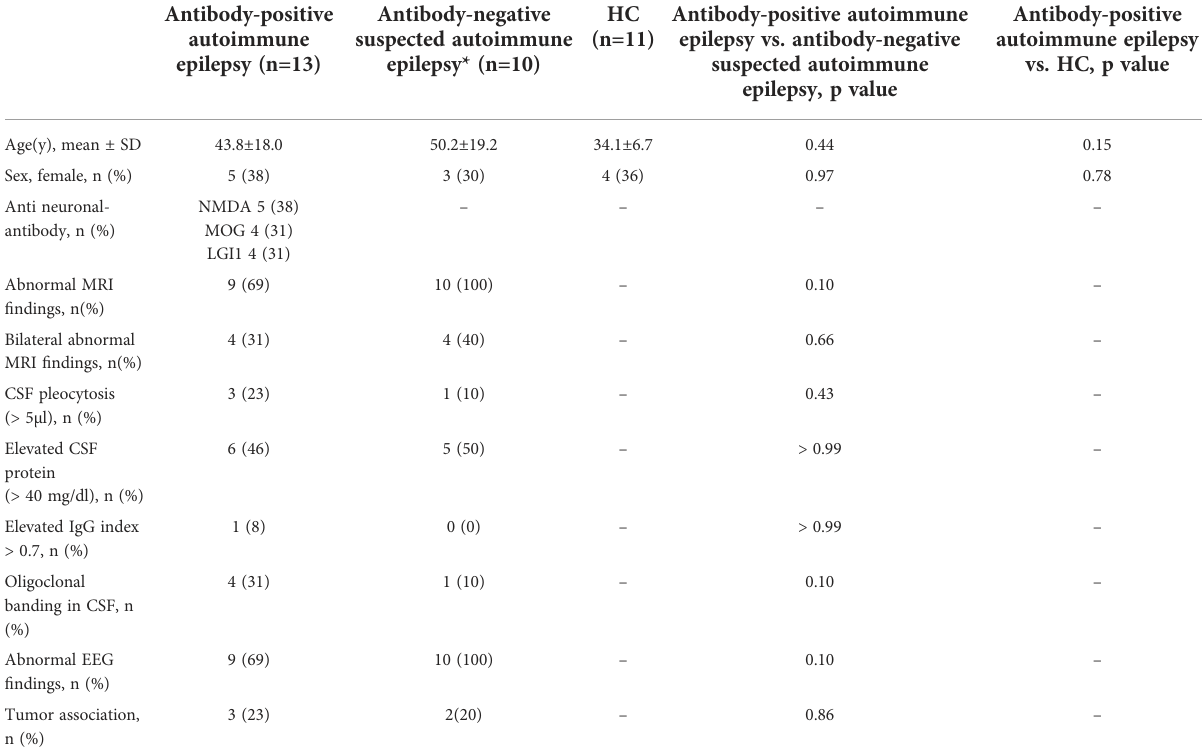
TABLE 1 Characteristics of patients with autoimmune epilepsy and